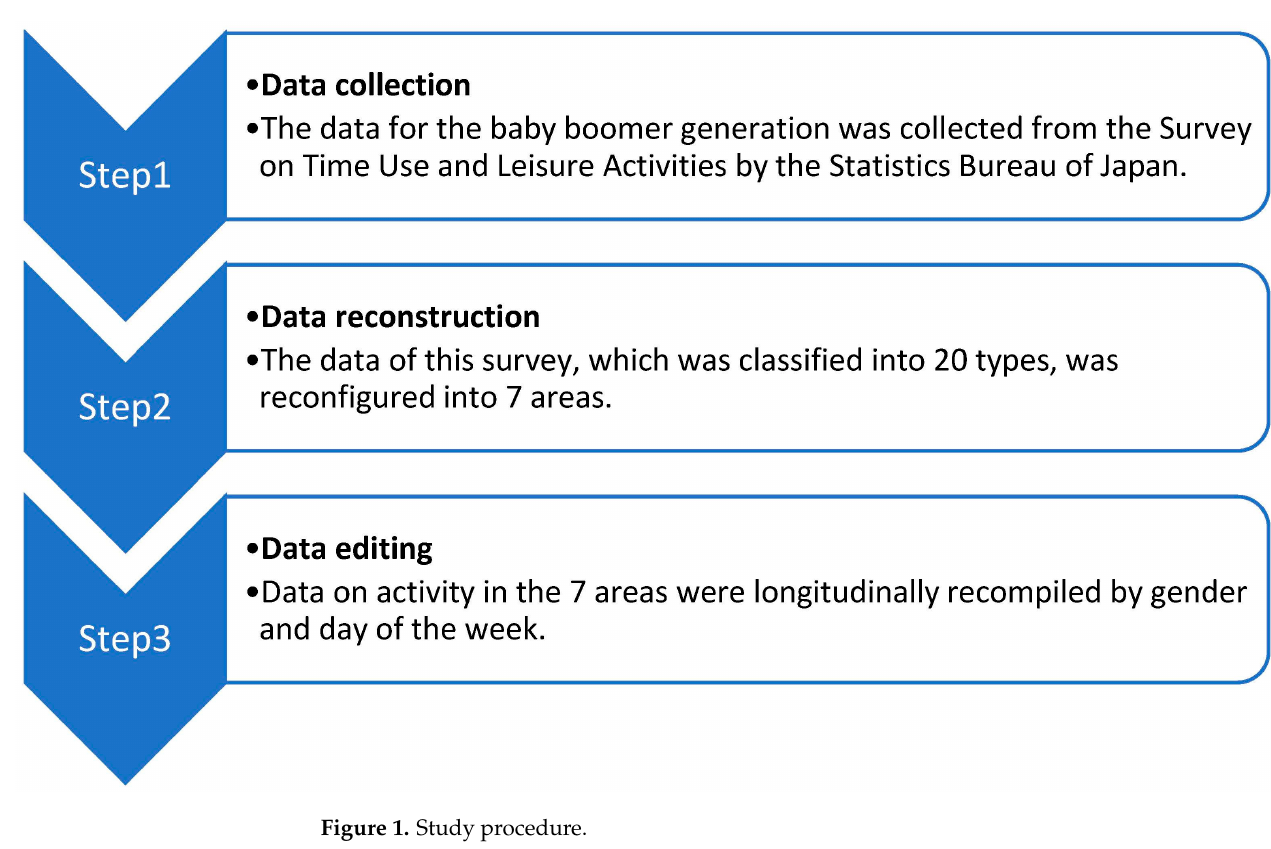
Figure 1. Study procedure.